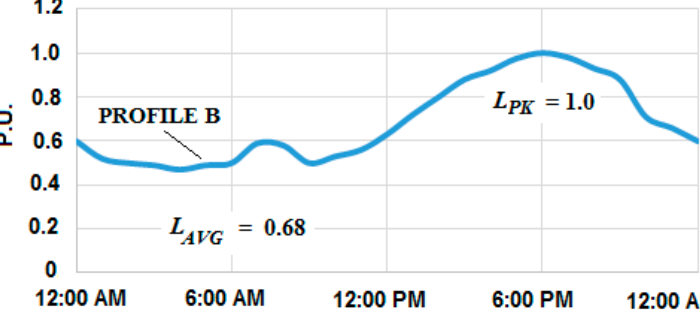
Figure 3. Historical cyclic load profile (Profile B) experienced by substation transformers.